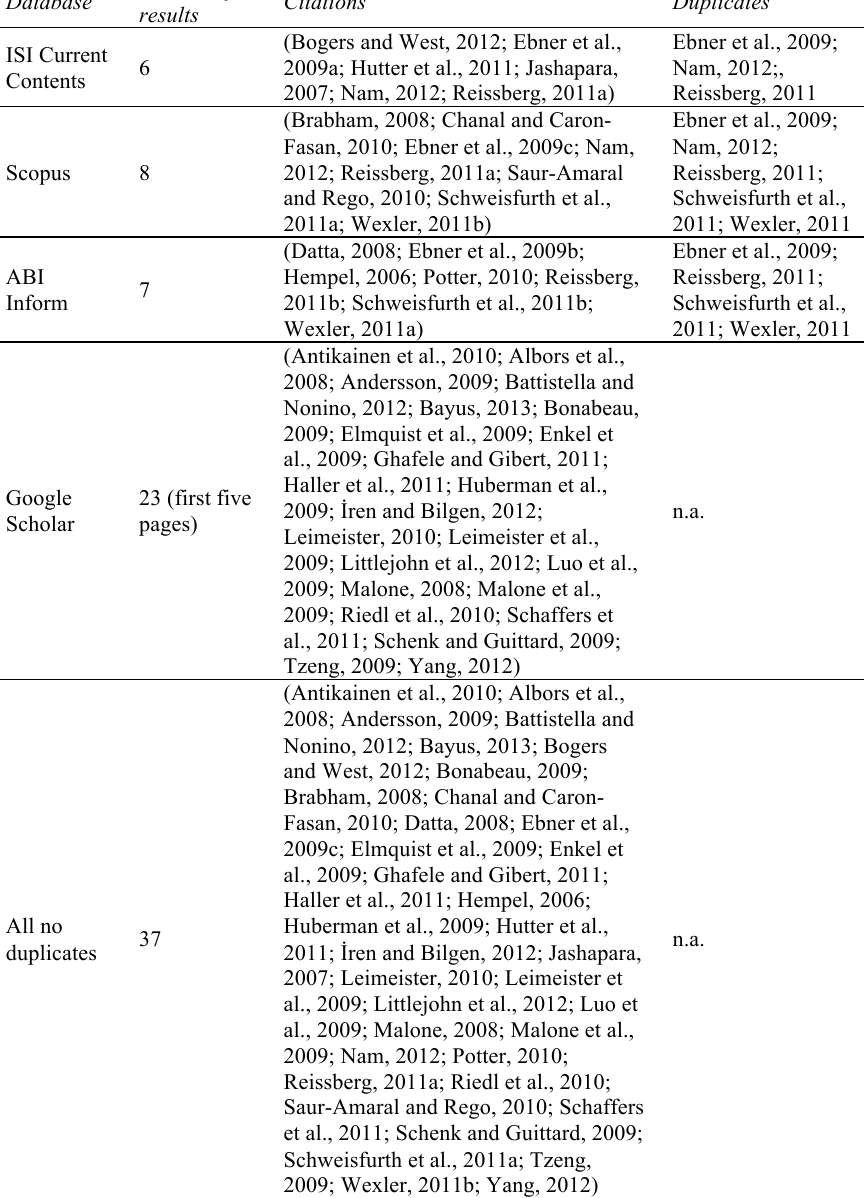
Table 3. Overview of data collection in the three databases and Google